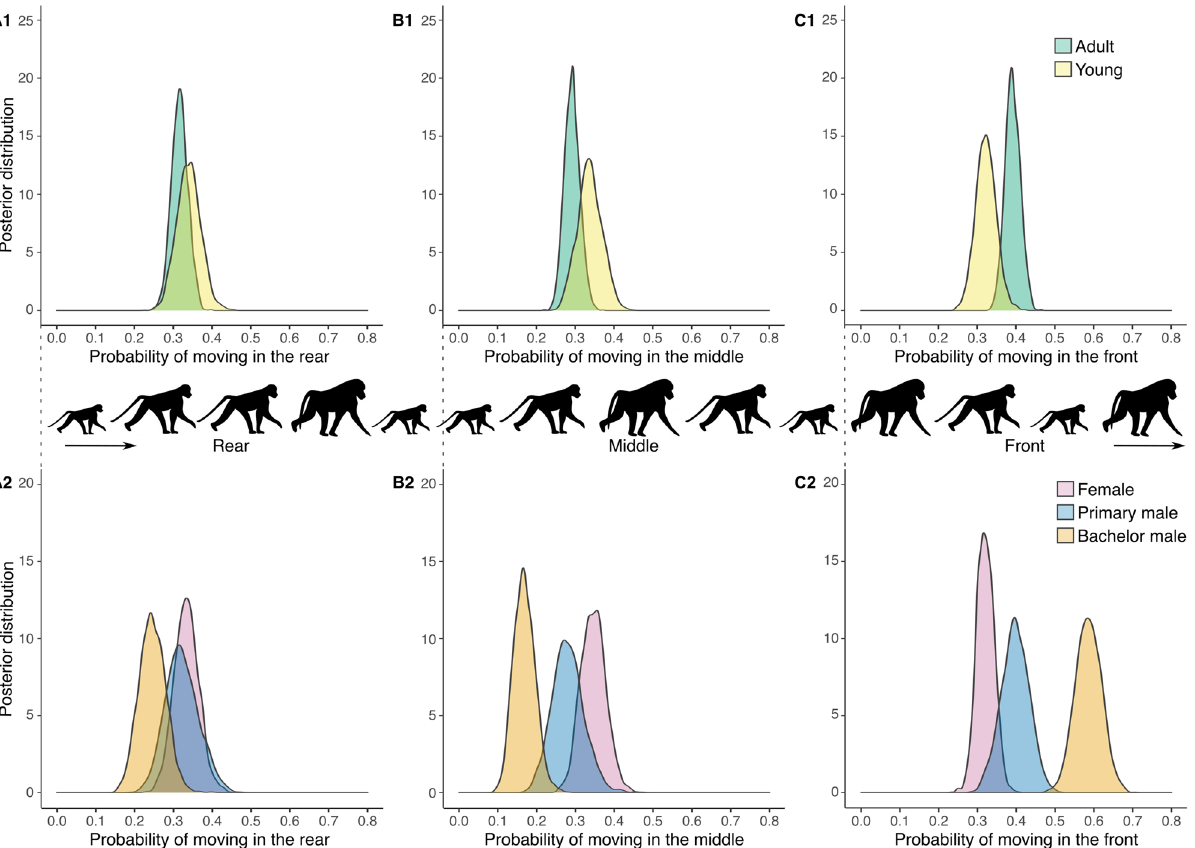
Figure 1. Posterior probability distributions to travel in the (A) rear, (B) middle or (C) front third of a group progression according to (1) age and (2) sex/reproductive status (adult subjects only). The distribution of relative frequency per category per third, i.e. estimated probabilities, in ESM. This figure was made using R (version 3.5.0, https:// www.R- proje ct. org) 84 .